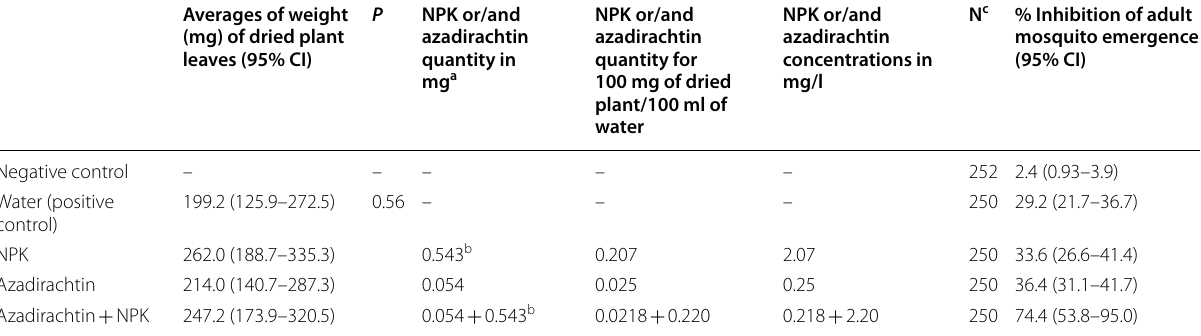
The inhibition percentage of Aedes albopictus adult emergence (95% CI) was assessed on 100 mg of dried plant in 100 ml of osmotic water for the experimental conditions: water (positive control), NPK fertilizer, azadirachtin insecticide alone and NPK carried out without dried chili pepper plants. The statistical analysis was performed using the one-way ANOVA test comparing the weight averages (Gaussian distribution) and the Kruskal Wallis test comparing the inhibition percentages of adult mosquito emergence (non-Gaussian distribution) a For the three foliar treatments b This NPK concentration corresponding to 0.21 mg of nitrogen (N)